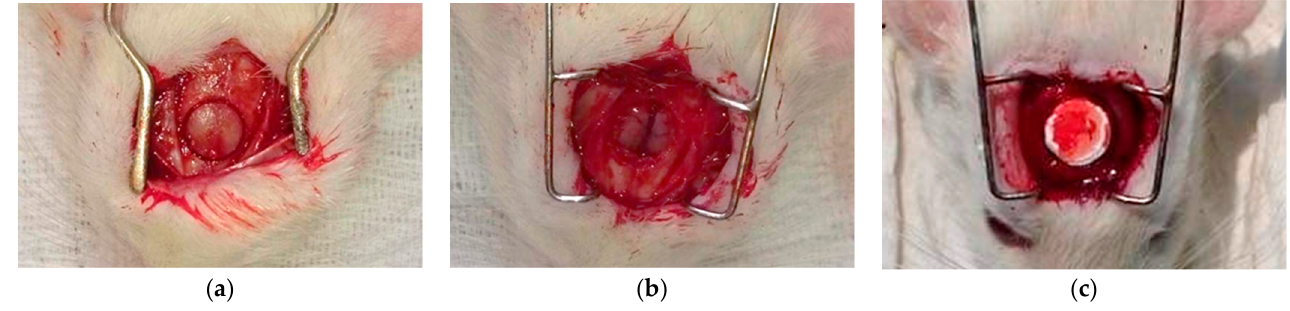
Figure 17. The surgical process for the critical size calvarial defects in rats. ( a ) Preparation of the 8 mm diameter full-thickness defect. ( b ) Surgical area after bone removal. ( c ) Implanted BTCP-AE-FM plate in the defective